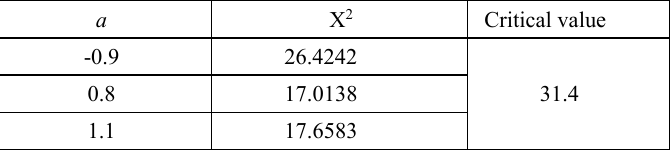
Table 4. Results of runs test.